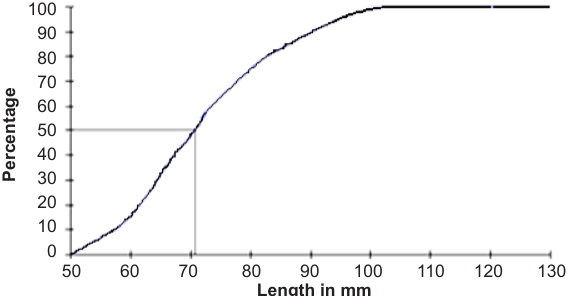
Figure 4. Size at first maturity of female S.